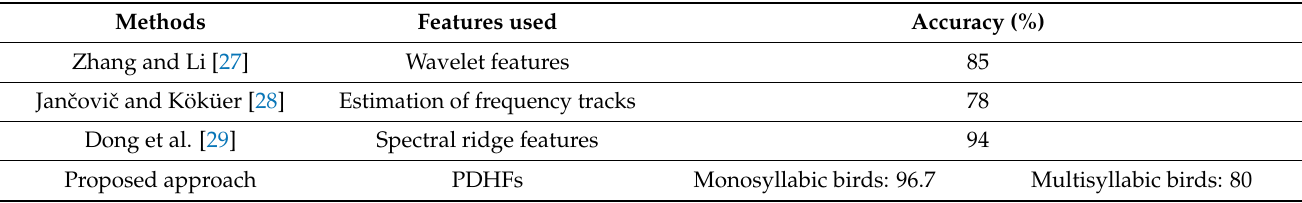
Table 8. Comparison of proposed methods with state of the art methods (PDHFs-Perceptual, Descriptive, and Harmonic Features).